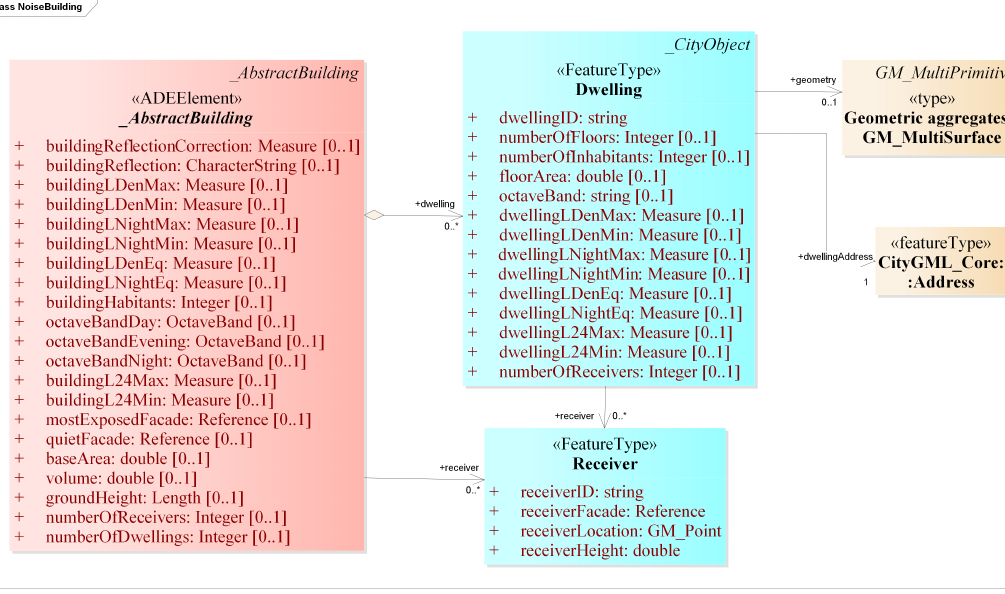
Figure 3. UML model of the _AbstractBuilding (shown in red) extended to include noise-related attributes and receiver information. A new feature type, Dwelling (shown in blue), is introduced to describe the self-contained unit of accommodation within the